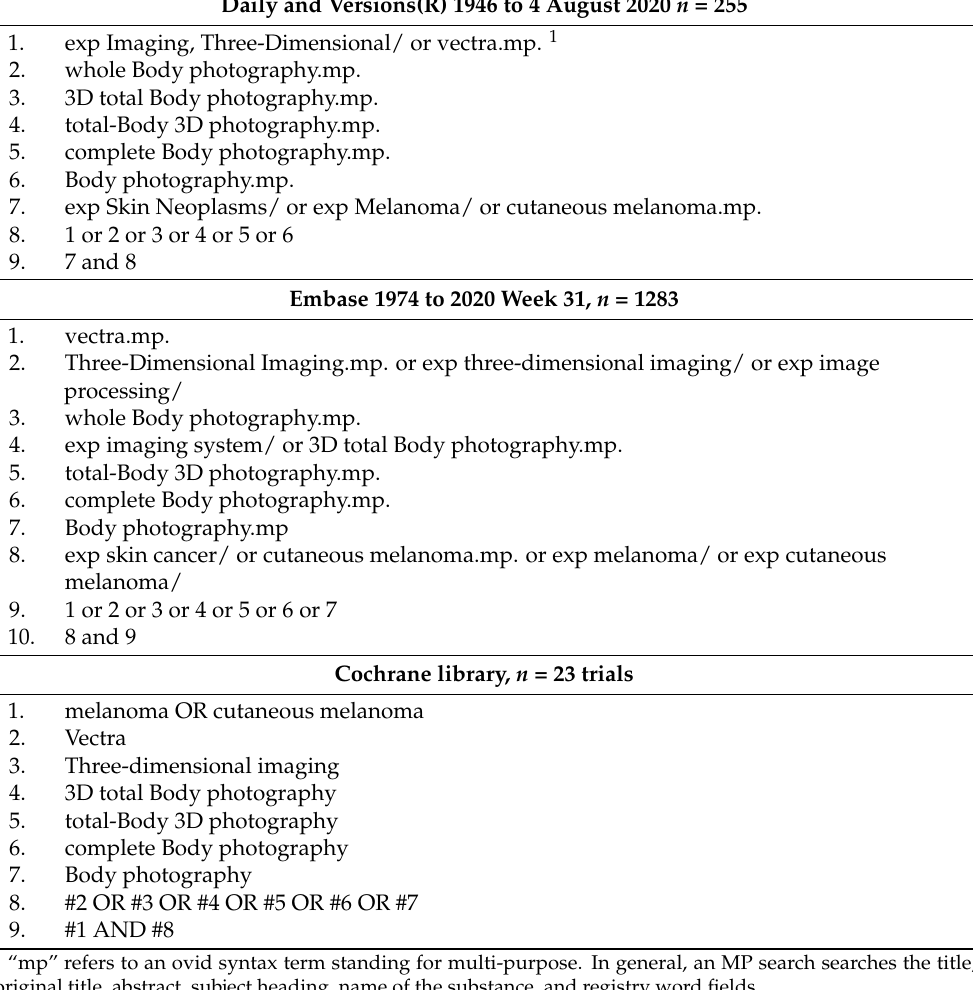
Table 1. Detailed Strategy of the Literature Identification Process. Ovid MEDLINE(R) and Epub Ahead of Print, In-Process & Other Non-Indexed